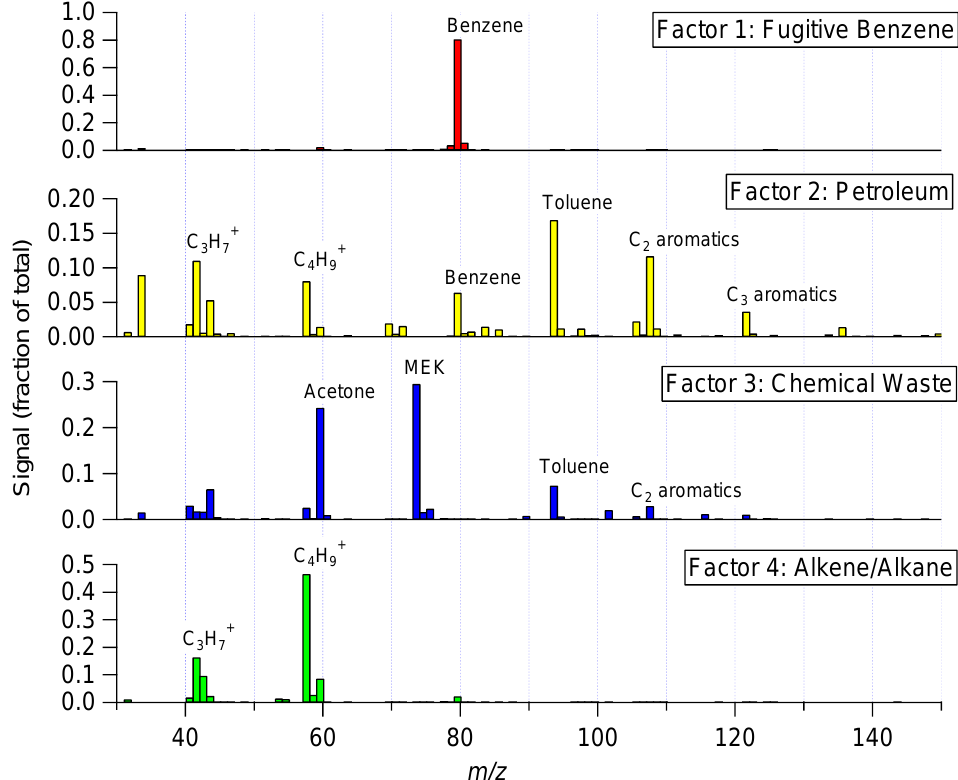
Figure 1. Mass spectral profiles for the four local factors.